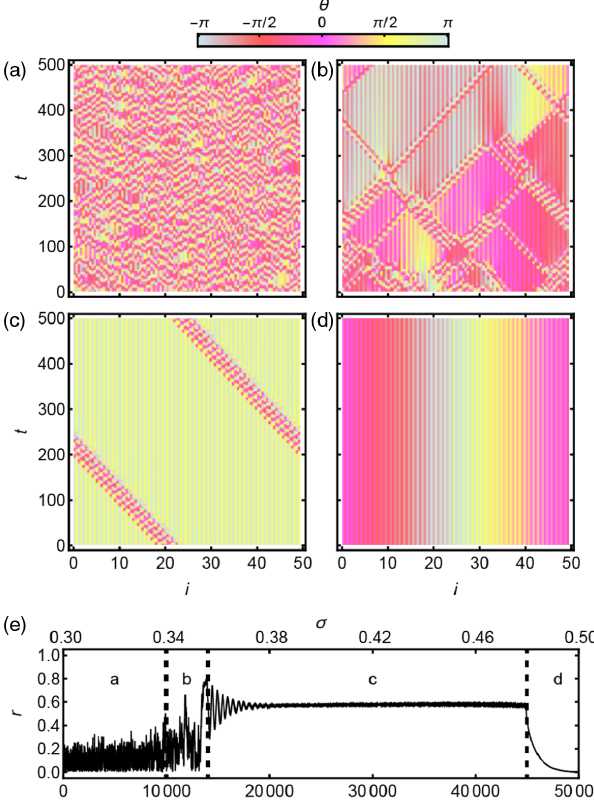
FIG. 4. Time evolution of various solution branches. (a) Asyn- chronous solutions, where each phase oscillator evolves inde- pendently with a mean frequency close to its natural frequency, are observed for small coupling constants. (b) Chimera inter- mittency, in which synchronous clusters intermittently appear and vanish, emerges as a transient from the asynchronous branch as the coupling constant increases past σ async c ≈ 0 . 34 . (c) Chimera solutions, in which a cluster of asynchronous oscillators coexists with a cluster of phase-locked oscillators, are observed for intermediate coupling constants. (d) Phase-locked solutions, where all oscillators evolve with the same mean frequency, are observed for large coupling strengths. (e) Order parameter r vs the time for a state undergoing quasistatic coupling constant variation from σ ¼ 0 . 3 to σ ¼ 0 . 5 . During the periods between the dashed lines, the dynamics resembles each of the states in (a) – (d). Animations of these states are available in Supplemental Material [9].